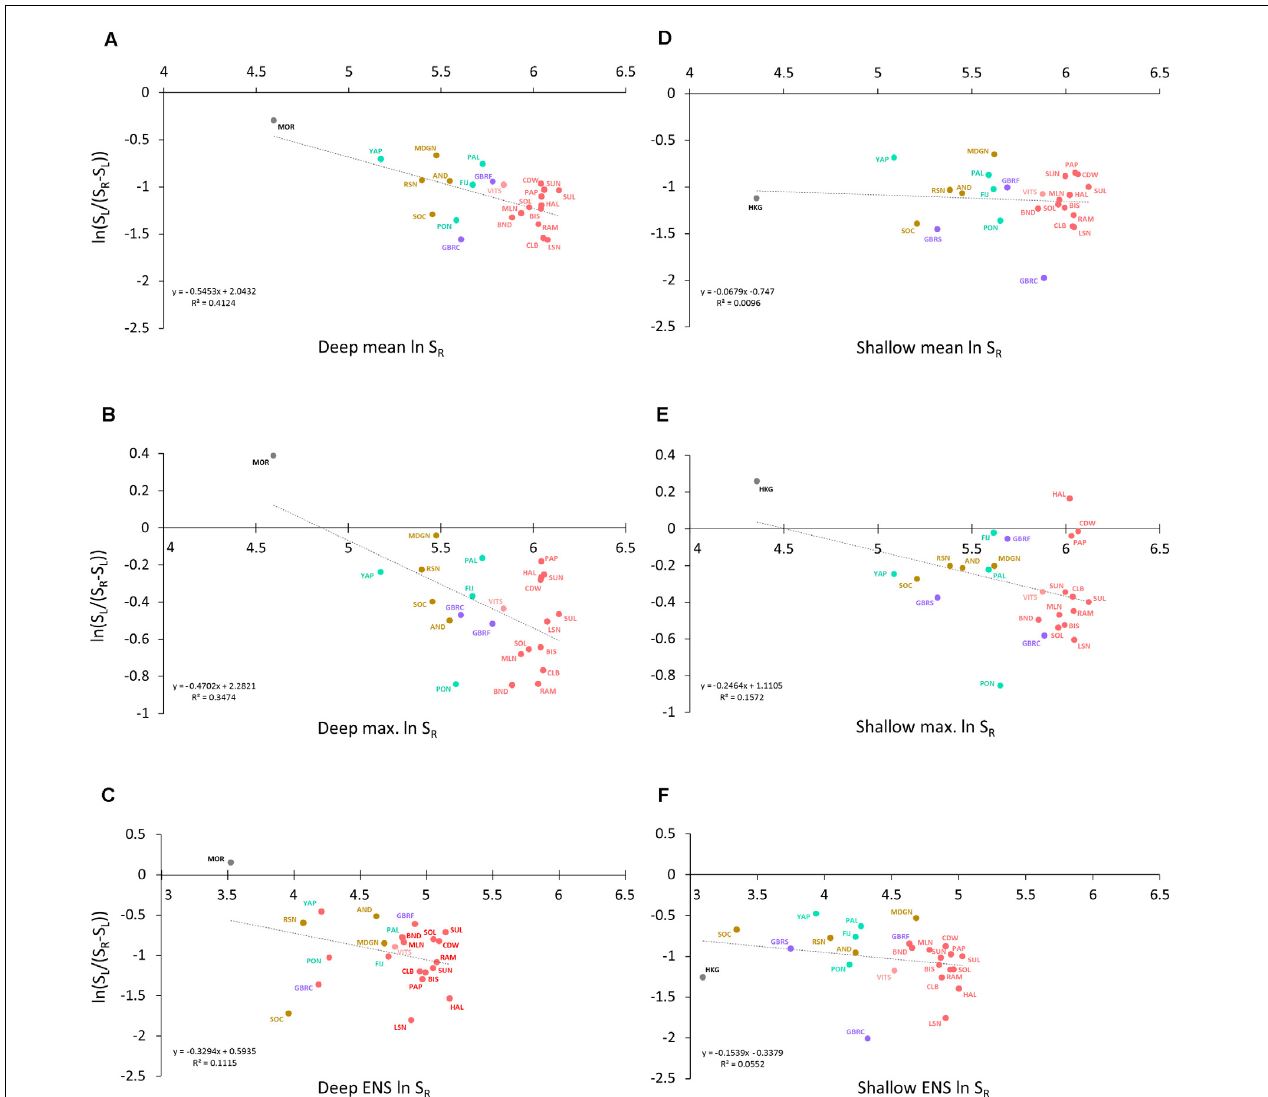
FIGURE 4 | Log ratio regressions of local–regional richness relations for (A) deep reef slope means, (B) deep slope maximums, (C) deep slope ENS, (D) shallow slope means, (E) shallow slope maximums, and (F) shallow slope ENS. Abbreviated ER names are those in Table 1 and Figure 1